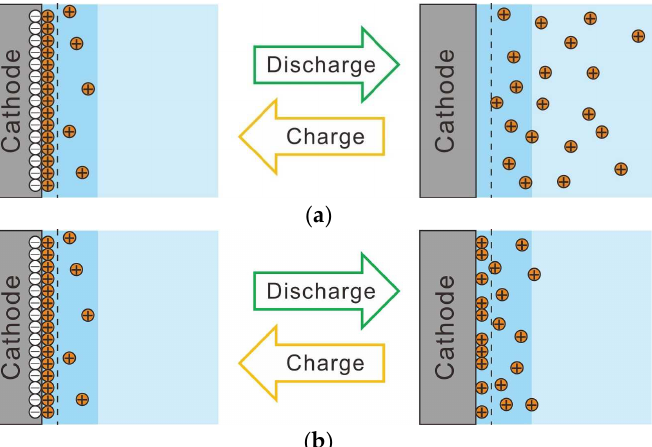
Figure 12. Measurement results of ( a ) particle site density (n = 27, mean ± S.D., * p < 0.05, Welch’s t test with Bonferroni correction) and ( b ) particle diameter (n = 45, mean ± S.D., * p < 0.05, Welch’s t test with Bonferroni correction) of P-Ni-CF plated using different OFF-times ( I = 200 mA, J = 3.79 A/m 2 , t ON = 10 ms, t = 5 s).